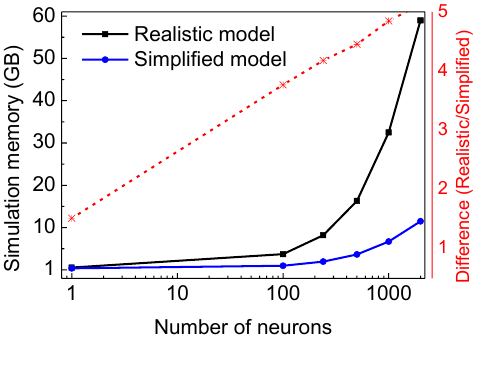
Figure 2. A sample three-dimensional representation of di ff erent neurons in the rat hippocampus which are traversed by single track of 600 MeV / u iron ion. An example of realistic (a) and simplified (b) networks of individual pyramidal neurons in the CA1 region. The main panel (c) shows the scaled model of hippocampal neurons (dorsal view); the DG granule cells are highlighted in blue, neurons in the subgranular zone - green, mossy fibers in the hilus - purple, CA1 pyramidal neurons - dark blue, and CA3 / CA2 pyramidal neurons - light blue. The energy deposition in track structure of iron ion is given in red